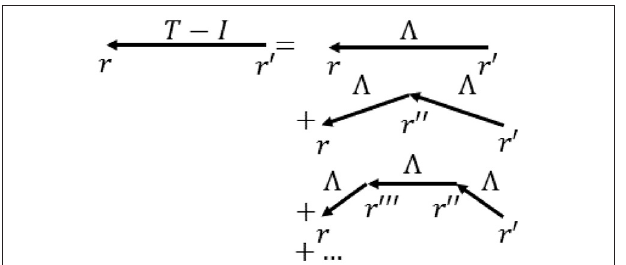
FIGURE 3 | Schematic of the terms in Equation (1) for propagation of activity to r ( r , t ) from r ′ ( r ′ , t ′ ). The total propagator T is the sum of terms = = representing direct input I plus, on the right, direct propagation 3 , propagation via neural interaction at one intermediate location r ′′ , and so forth. Most commonly arrows indicate propagation between cortical locations via white matter fibers, while vertexes denote points where local interactions occur, including via corticothalamic